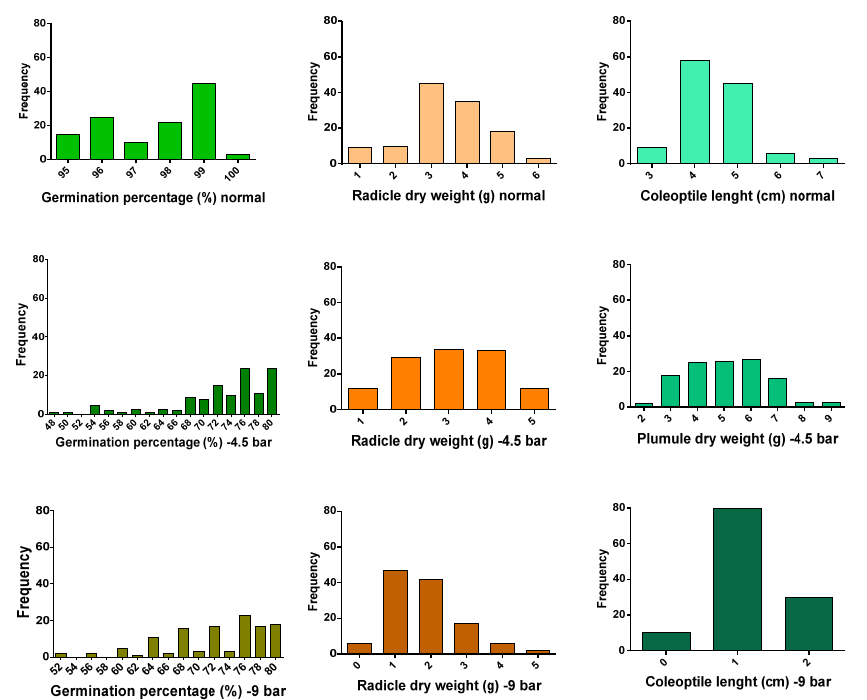
Figure 2. Phenotypic distribution of traits under normal conditions and drought stress levels ( − 4.5 and − 9.0 bar) in 120 F8 families at the germination stage. X is the value of the traits, and Y is the frequency.